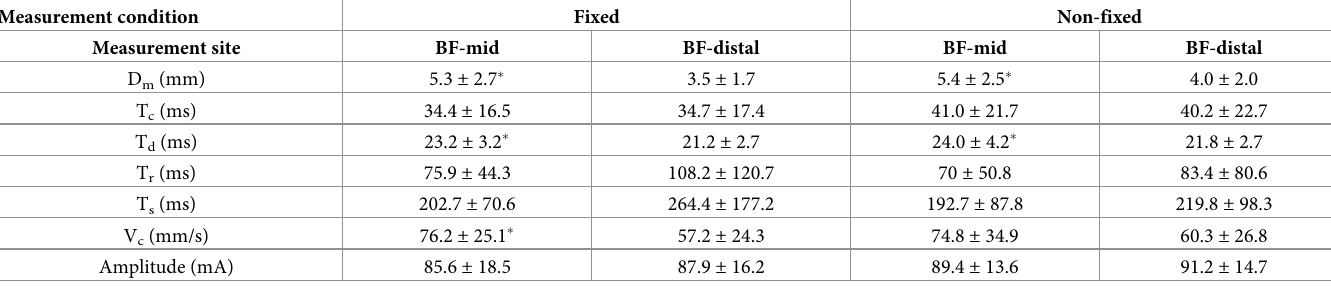
Table 2. Descriptive overview of all TMG-derived parameters.